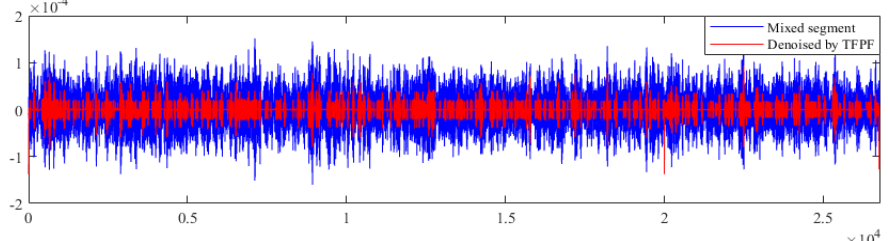
Figure 14. The comparison of mixed segments before and after denoising by TFPF.